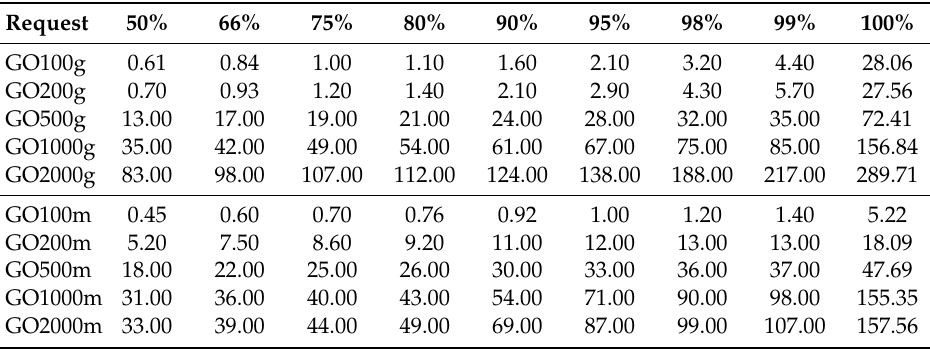
Table 12. Percentage of getObservation requests completed within given times (in seconds) for the di ff erent configuration of concurrent users and WSGI server (case